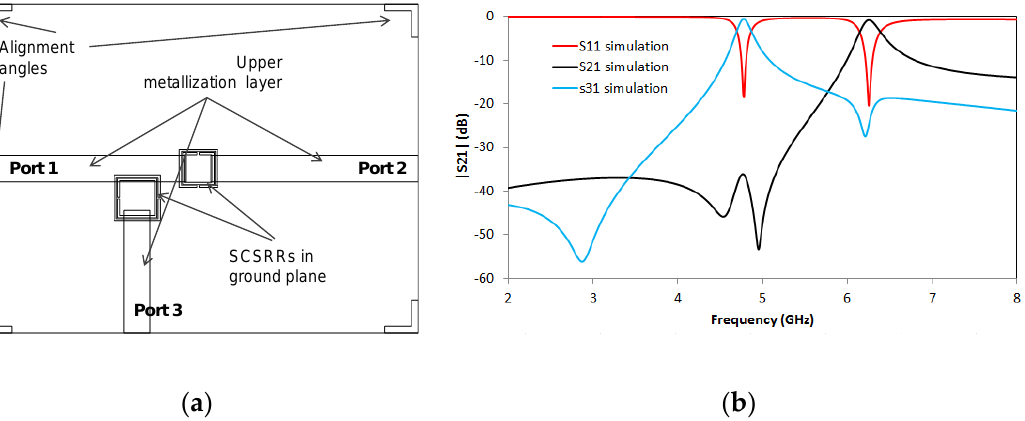
Figure 21. ( a ) Top view overlapped layer distribution of a 2-layer duplexer. ( b ) Simulated S11 (dashed red line) and simulated S21 (dashed black line) and simulated S31 (dashed blue line).